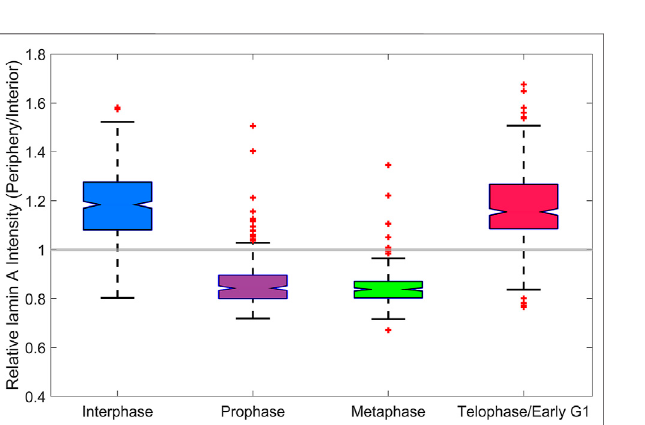
FIGURE 6 | CP results for lamin A in the G1 and S phases in MF cells. NormalizedCPcurvesofGFP-laminAintheG1phase(red)andintheSphase (blue).Theintersectionofthelinearlong-time fi t(thedashedblackline)andthe y -axis shows the free fraction (85 ± 5% of lamin A in the G1 phase and 75 ± 5% lamin A in the S phase). The red and blue shaded areas above and below each curve refer to the STD of the measurements. Data were derived from ∼ 65 measurements at each